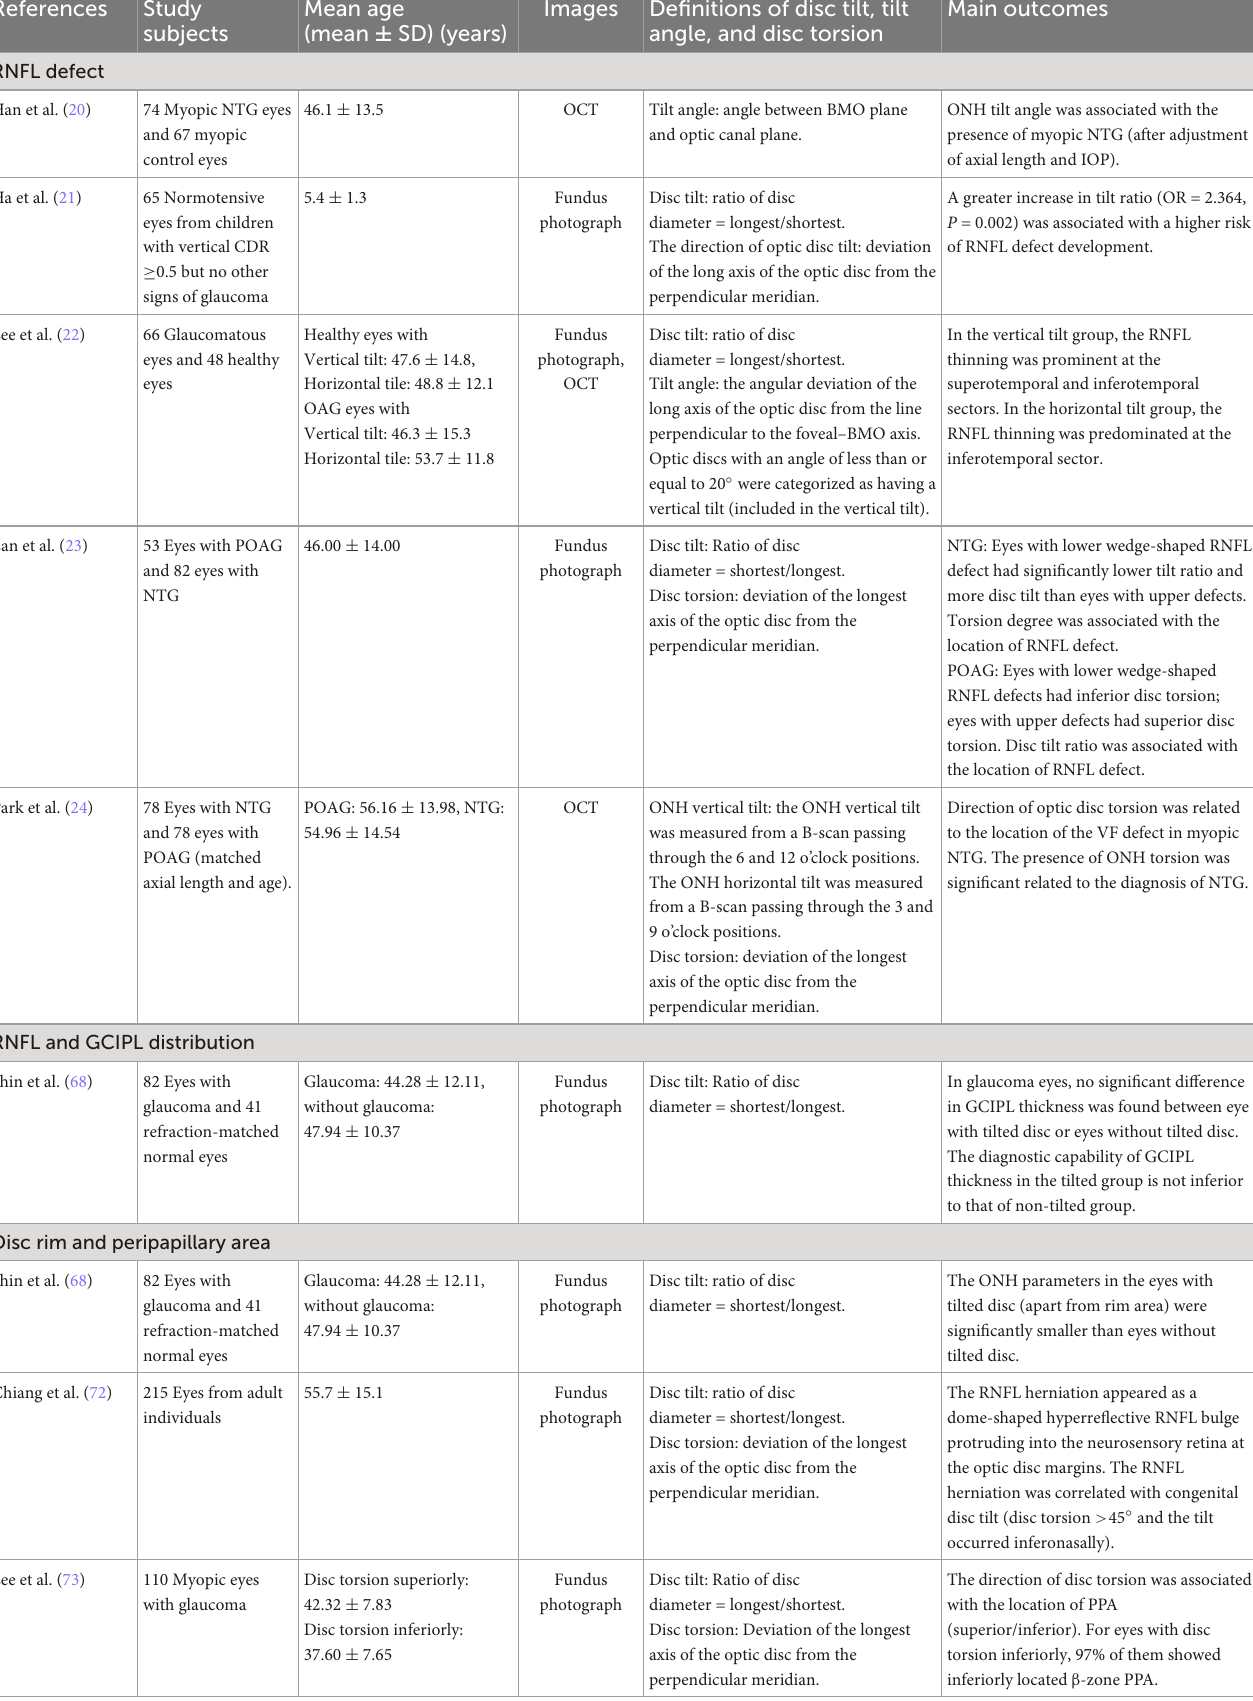
TABLE 2C Structural change associated with myopic tilted disc in myopic eyes with